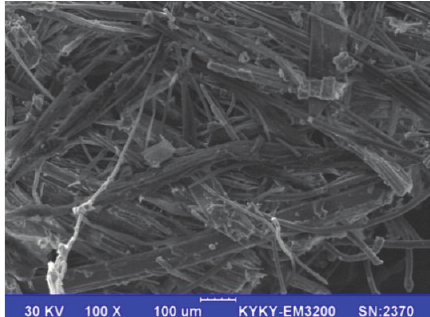
Figure 2: SEM of composite material at 100x.